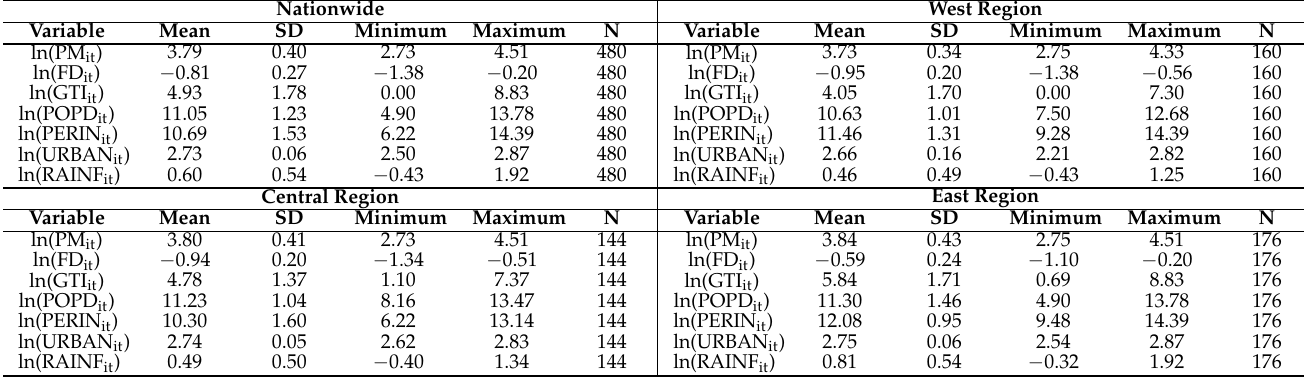
Table 1. Table 1. Descriptive statistics of the variables.